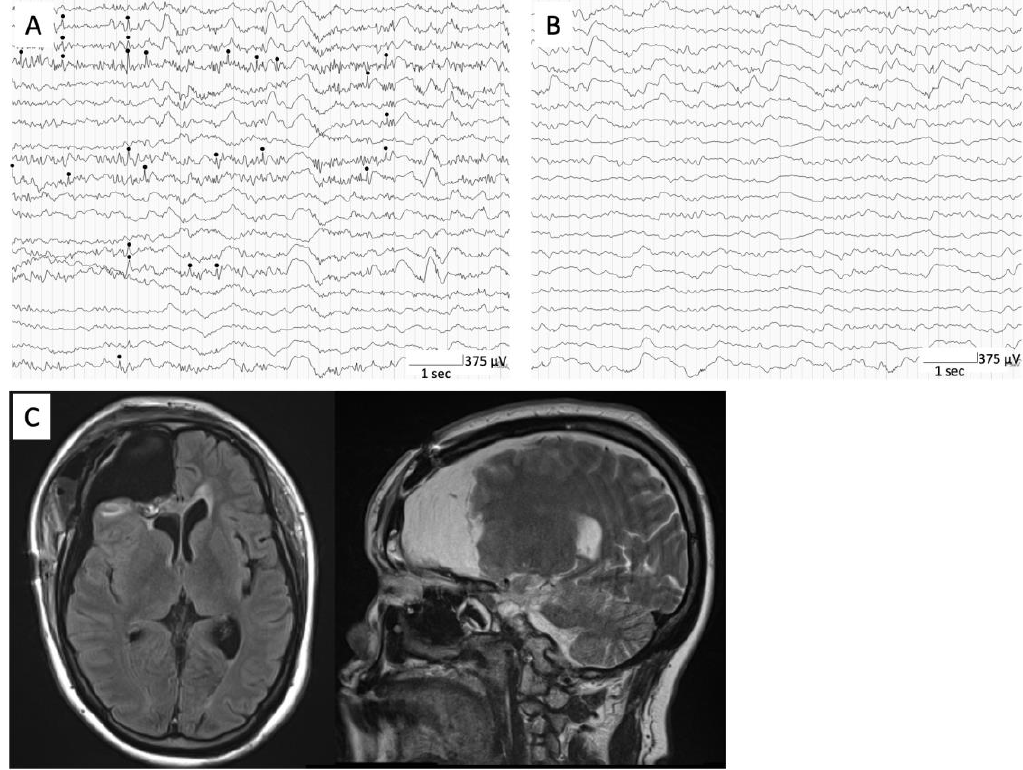
Figure 2. Intraoperative ECoG showing interictal epileptiform discharges (black circle) at right frontal lateral cortex ( A ). Postoperative intraoperative ECoG showing no obvious interictal epilep- tiform discharges at surrounding frontal lobe ( B ). Postoperative MRI showing adequate frontal lobectomy ( C